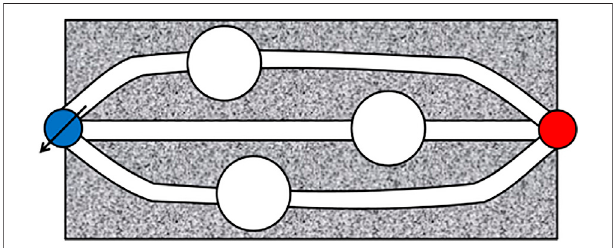
FIGURE 15 | Physical model of multicavity in parallel in one injection- production well.